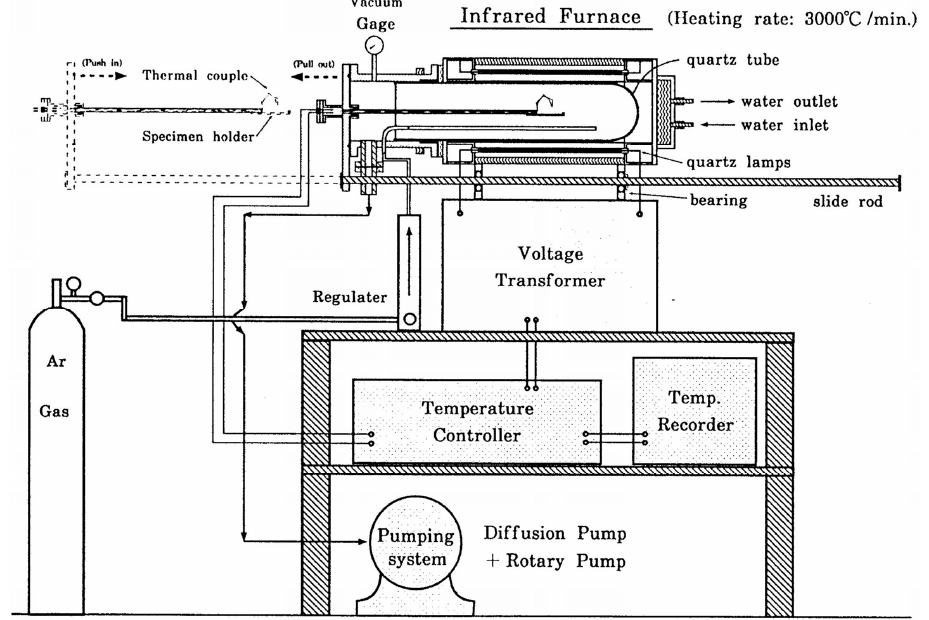
Figure 2. The schematic diagram of infrared brazing furnace.